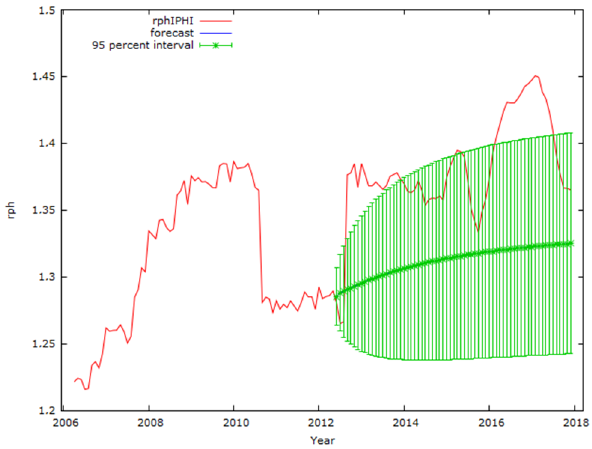
Figure A7. Time series forecasting for IPHI, the in-sample January 2000–May 2012, and the out-of-